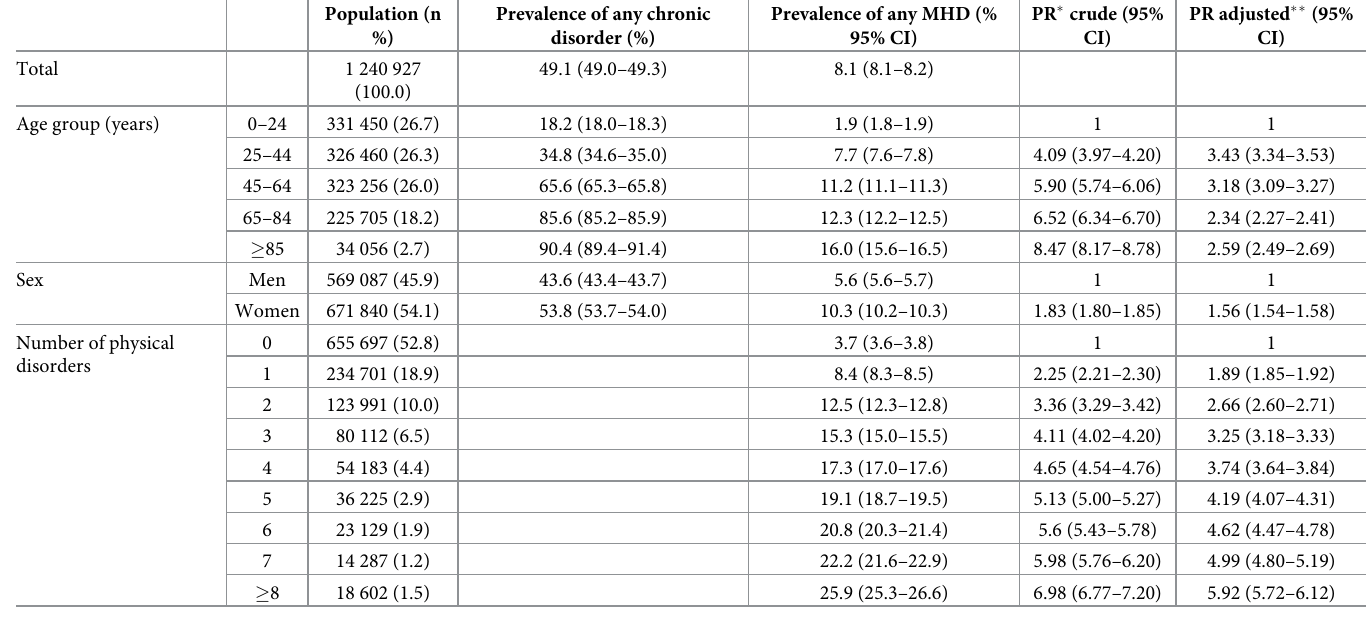
Table 1. Prevalence of any chronic disorders, MHDs, and association of MHDs with physical